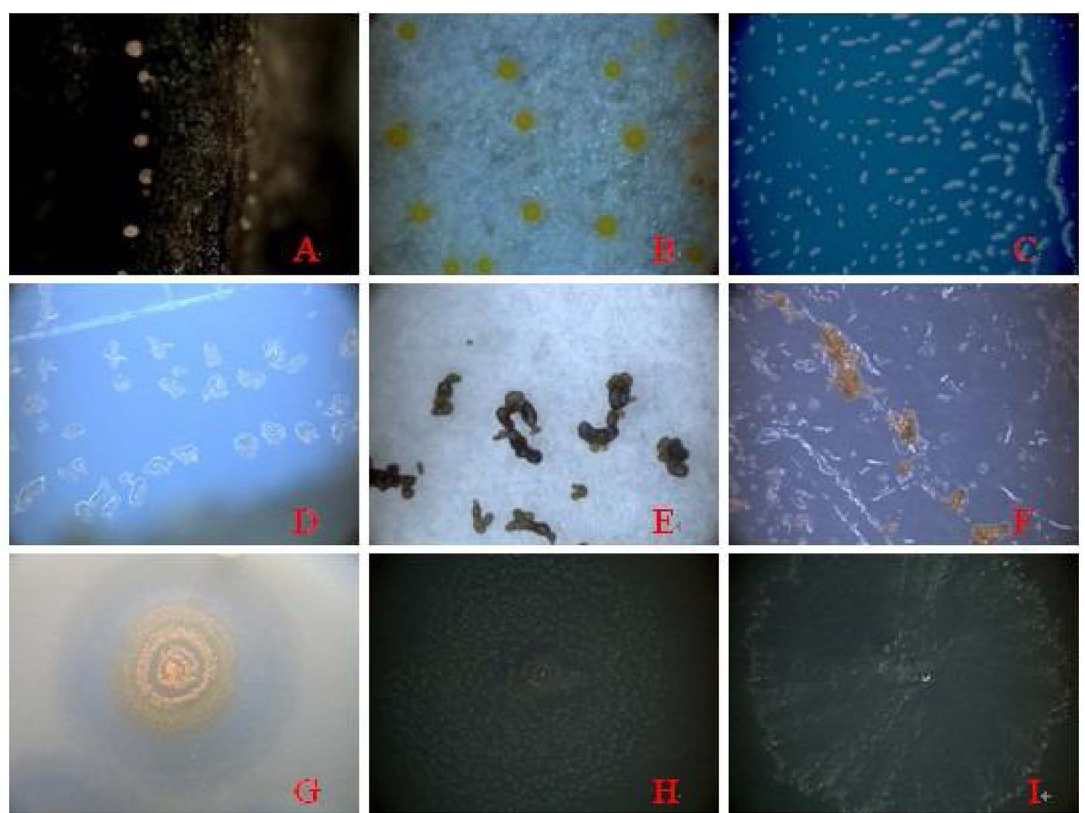
Figure 1. Morphological characteristics of myxobacterial fruiting bodies.